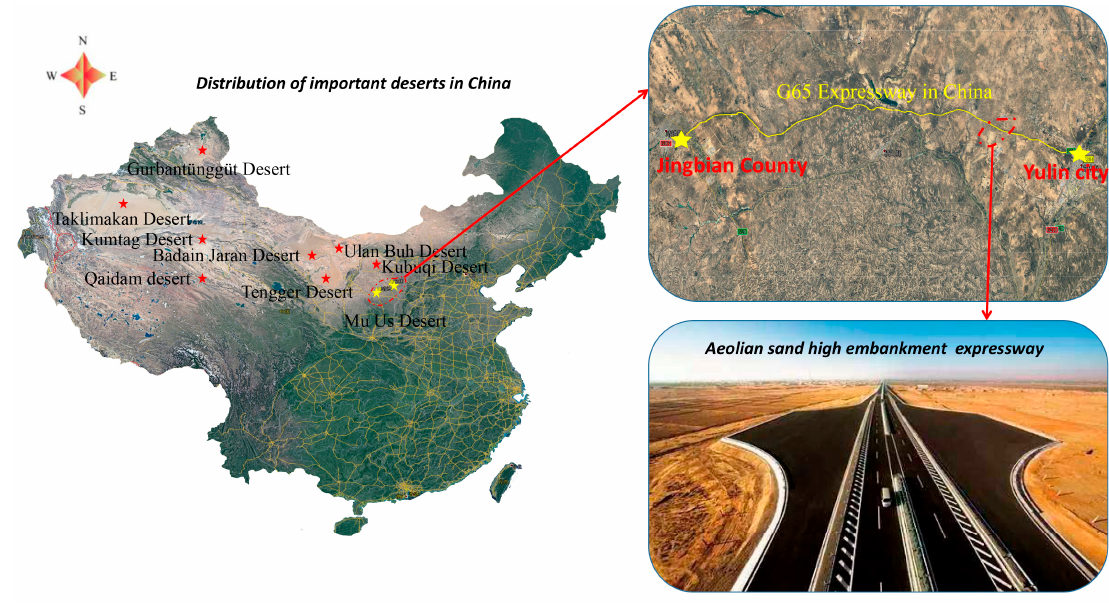
Figure 1. Location of this research.